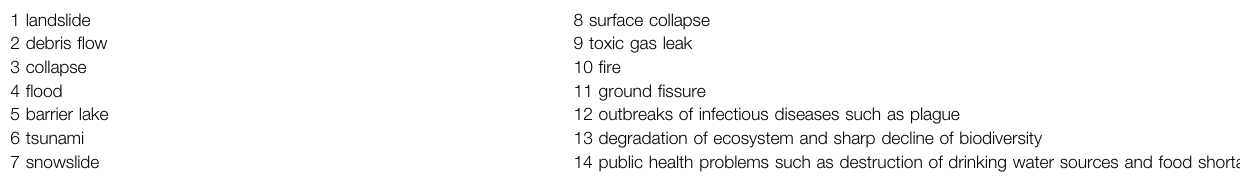
TABLE 1 | The potential secondary disasters caused by earthquakes.